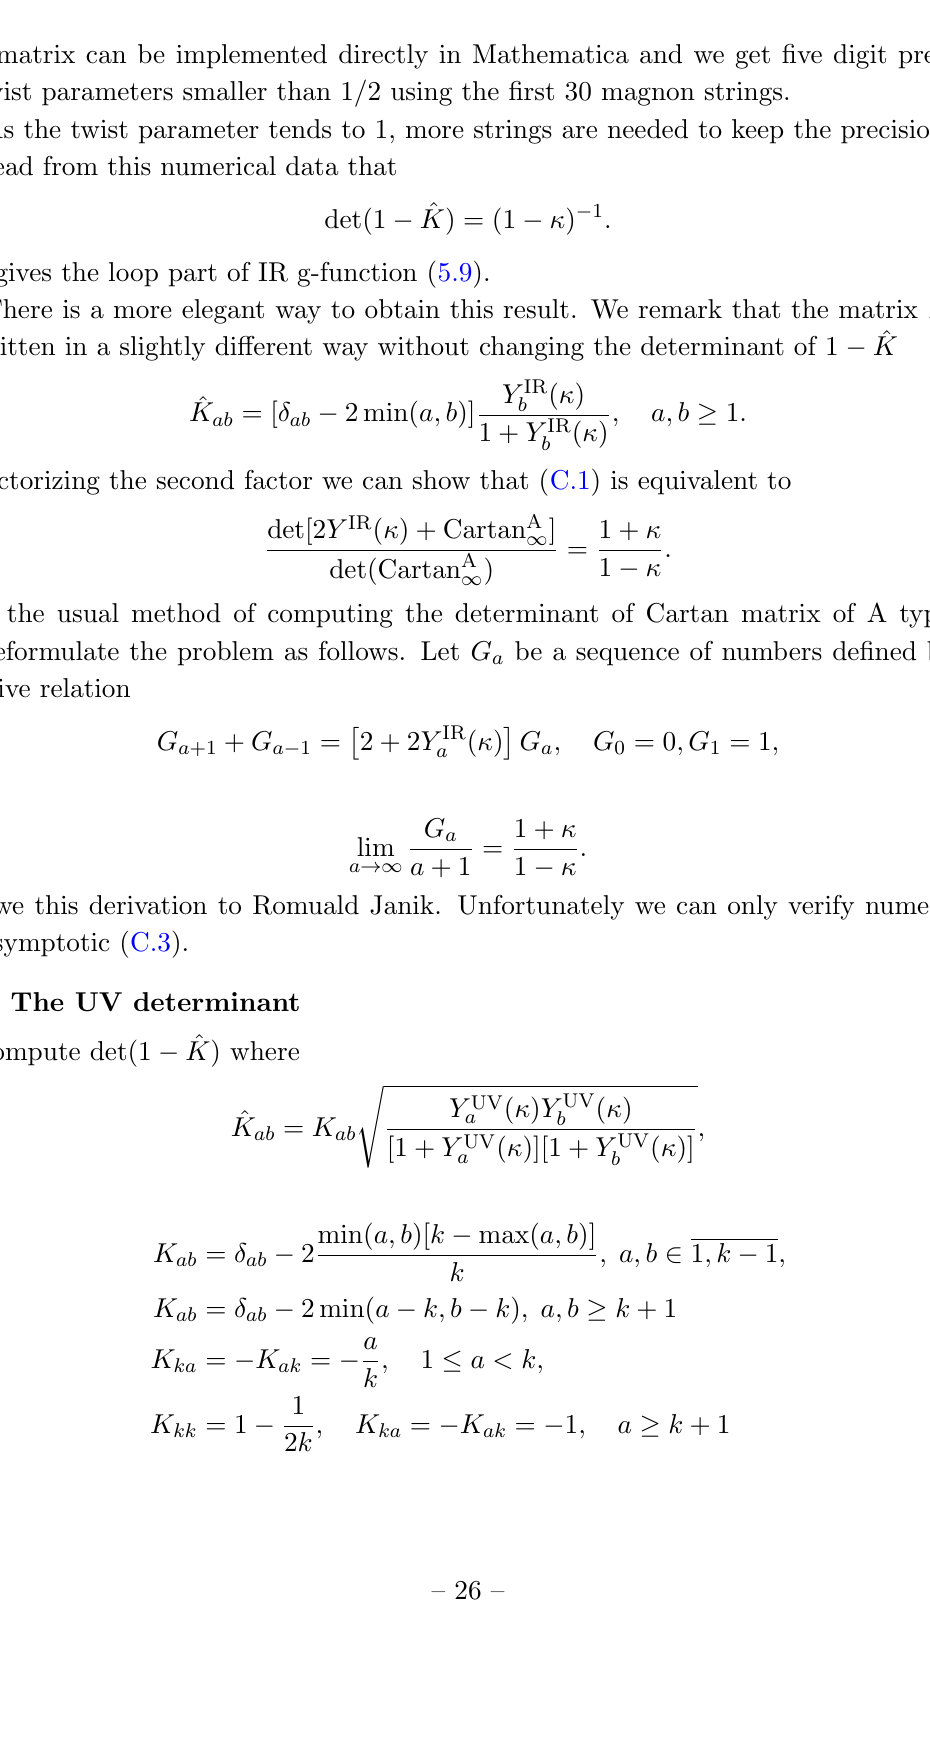
Table 1 . Approximation of [det(1 (cid:0) ^ K )] (cid:0) 1 for some values of the twist